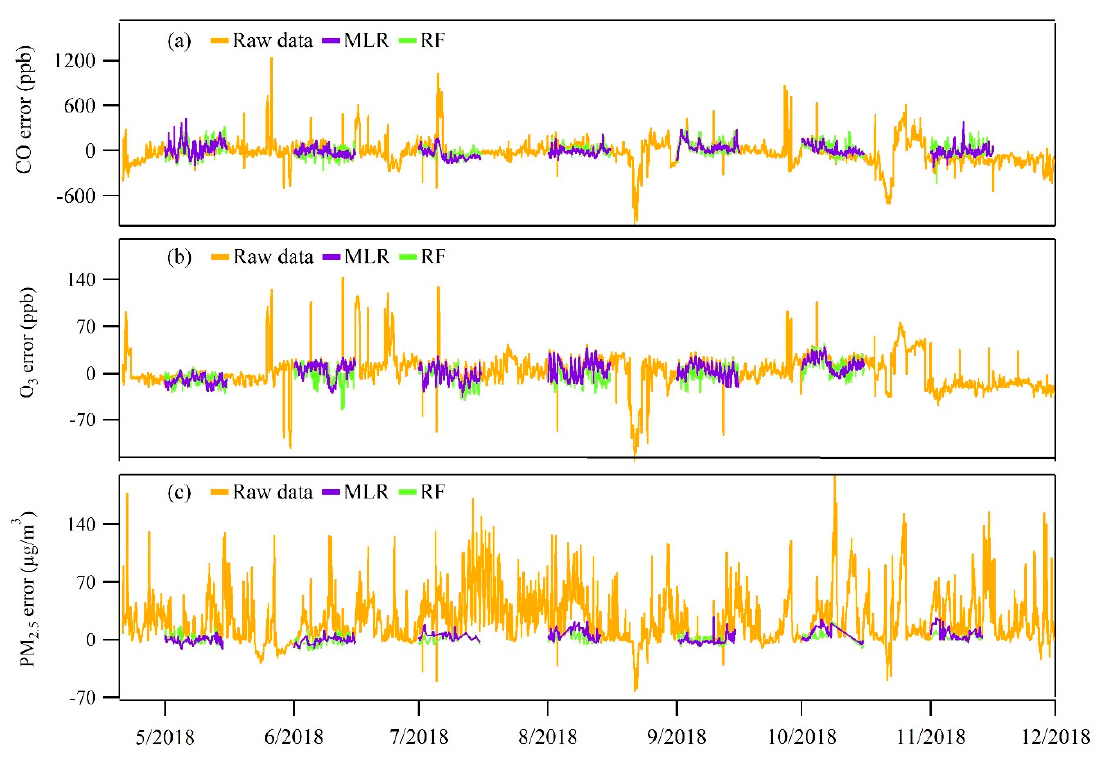
Figure 4. The difference between the sensors’ data and the reference data, (a) CO, (b) O 3 , and (c) PM 2.5 . MLR: multi-linear regression, RF: random forest.